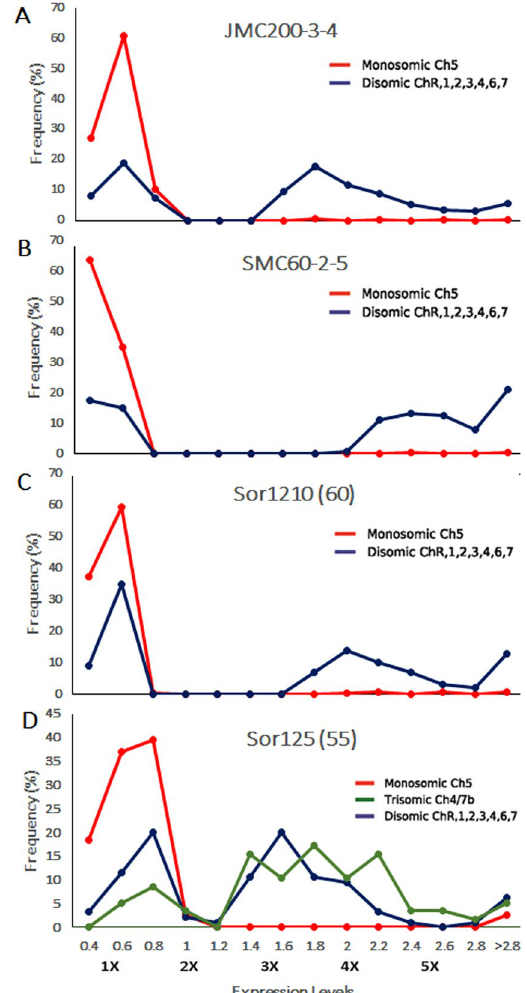
Figure 1. Distribution of differentially expressed genes present on monosomic Ch5 or trisomic Ch4/7b genes over expression levels. ( A , B , and C ) Distribution for monosomic Ch5 genes that were significantly different (CuffDiff2 at p < 0.05) in mutant strains [JMC200-3-4, SMC60-2-5, and Sor1210(60), as indicated]. ( D ) Distributions for monosomic Ch5 genes and the trisomic Ch4/7b genes that were significantly different (CuffDiff2 at p < 0.05) in Sor125(55). X-axis represents expression levels of the genes in mutants compared to parental strains and Y-axis represents the frequency of genes. Red lines represent genes on monosomic Ch5, blue lines represent genes on disomic chromosomes, and green line (in D) represents genes on the trisomic Ch4/7b. For RNA-seq analyzed mutants JMC200-3-4, SMC60-2-5, and Sor1210(60), for each of the significantly different gene, we derived the ratio of the level of expression averaged from three independent reads from each mutant strain compared to that observed in the corresponding parental strain. For expression array analyzed Sor125(55) we derived three independent sets of ratios for every mutant/parent pair, and plotted the average of the three bin sets (see also Materials and Methods). Note that genes exhibiting no significant expression changes are excluded from these graphs, including transcriptionally compensated genes on aneuploid